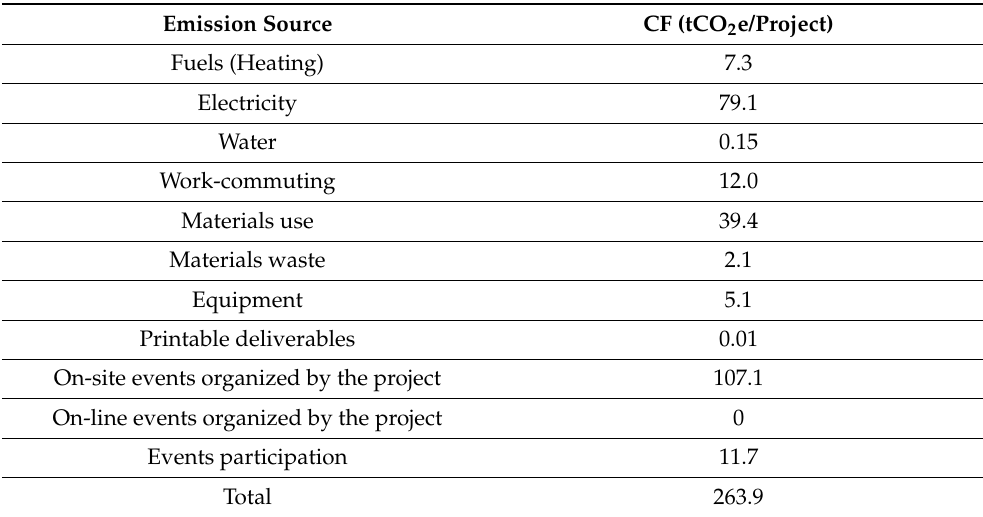
Table 3. Carbon Footprint (in tCO 2 e/project) for the base case scenario during the whole REMEDIO project period.